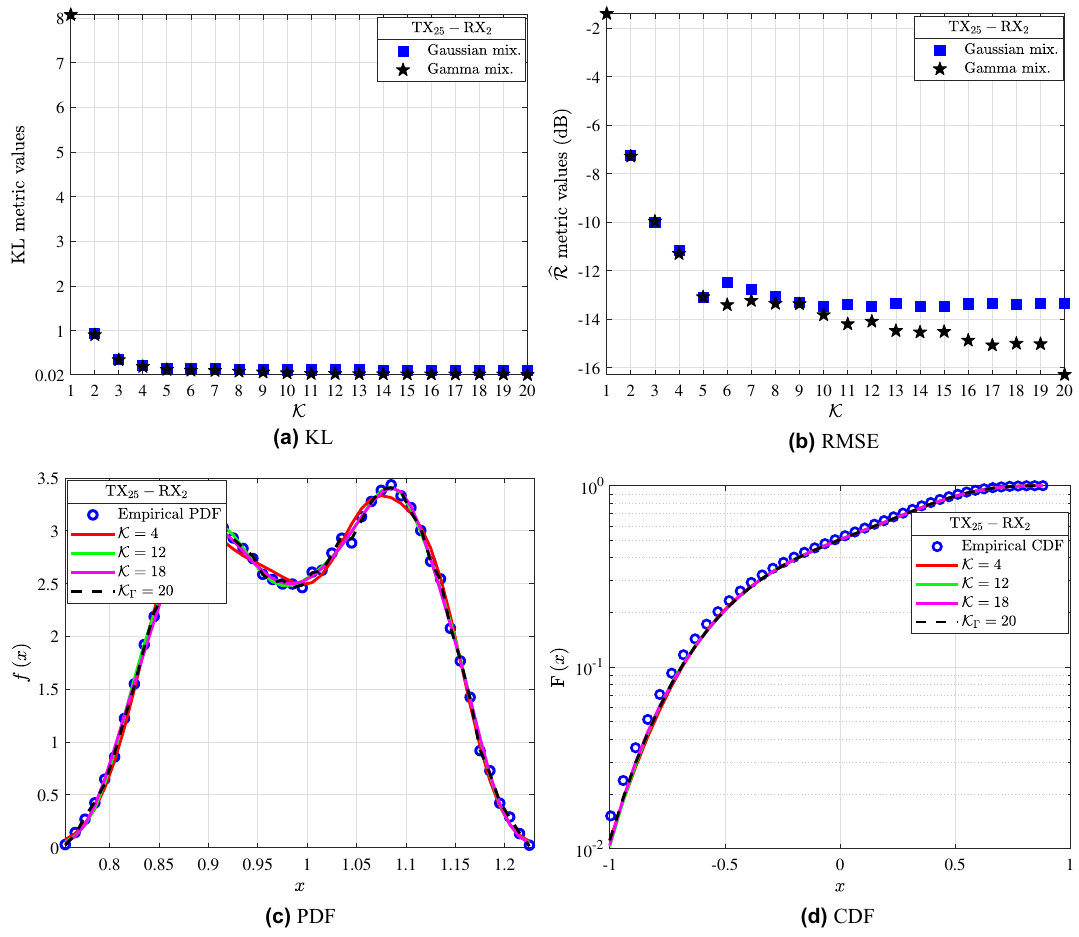
RX 2 : ( a ) KL and ( b ) R metrics for different values of K for the GMs and MGs. ( c ) Fitting of the Figure 4. TX 25 − PDF and ( d ) CDF analytical GM and MG expressions to the empirical channel gain (cid:31)